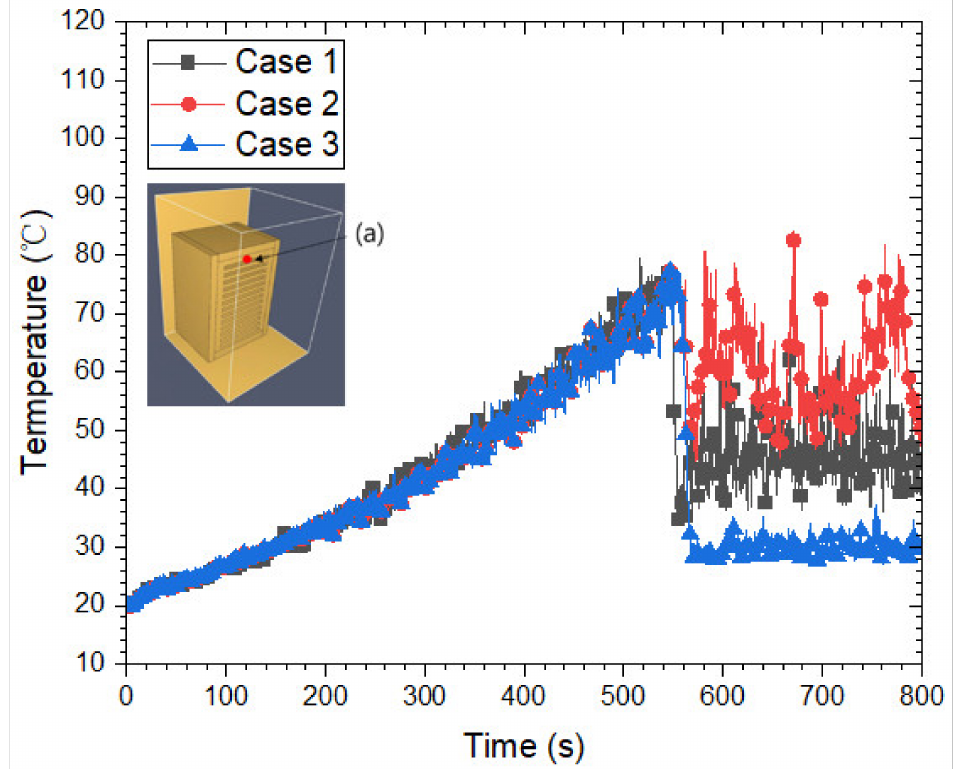
Figure 5. Temperature variation at the louver, ( a ): measurement point.